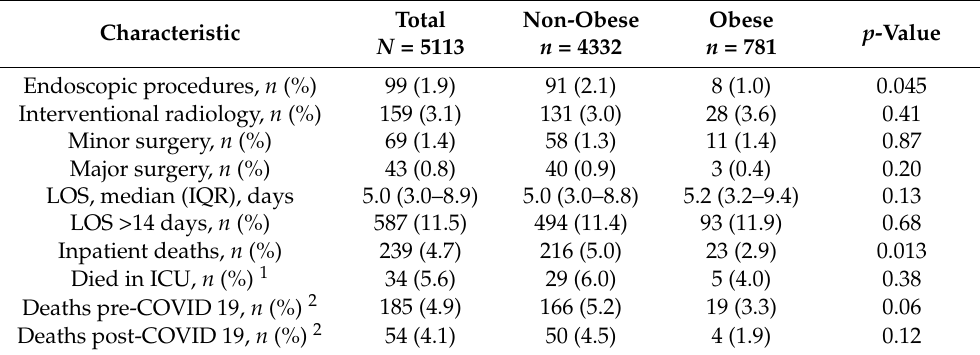
Table 7. Procedures, inpatient length of stay and mortality by obesity